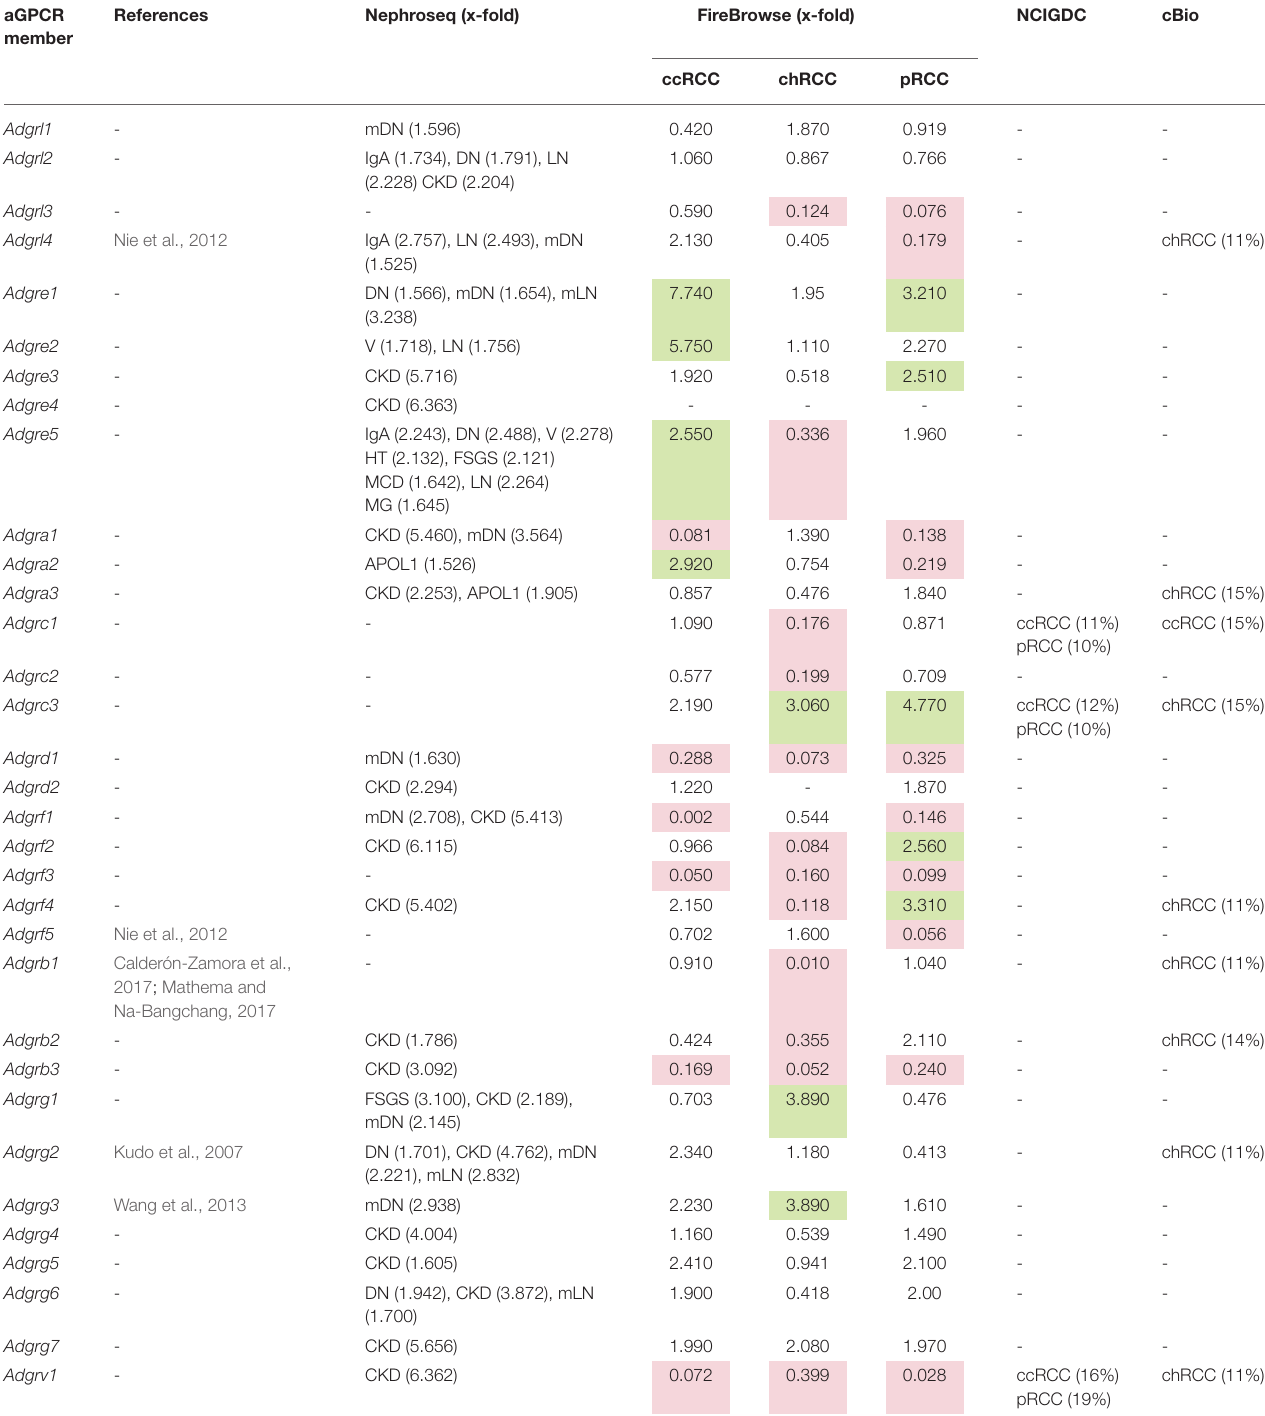
TABLE 2 | Adhesion GPCRs associated to kidney disease. aGPCR